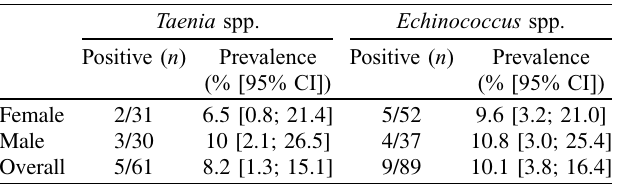
Table 2. Non Human Primate seroprevalences for Taenia spp. and Echinococcus spp. according to species. Species Parks Taenia spp. Echinococcus